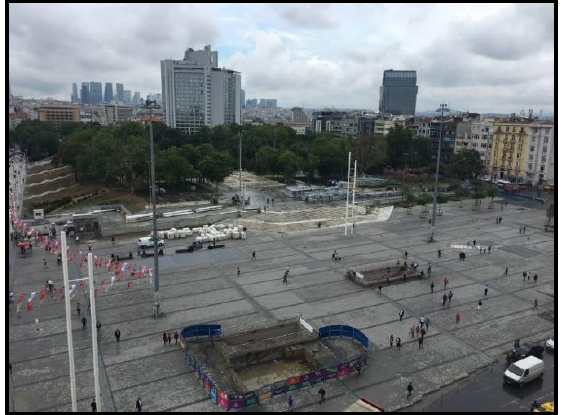
Figure 7. A view from Taksim square during the pedestrianization project works. Gezi Park remains in its place (Taksim Meydanı Çevre Düzenleme İnşaatı,